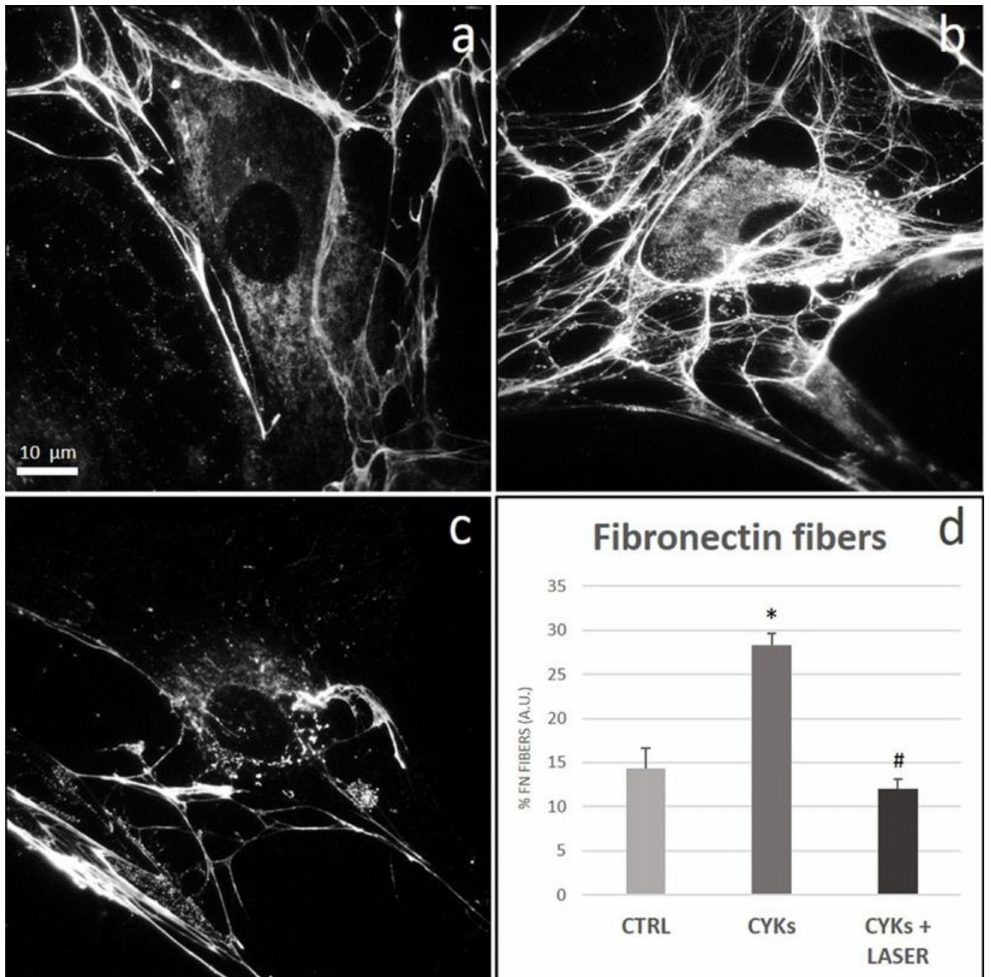
Figure 7. Effect of laser treatment on fibronectin expression and organization. Microscopy analysis of fibronectin expression evaluated by immunofluorescence (magnification 100 × ) on NHDF in basal conditions (CTRL; panel ( a )), stimulated with IL-1 β and TNF- α for 48 h (CYKs; panel ( b )), stimulated with IL-1 β and TNF- α for 48 h and then exposed to laser treatments (3 treatments, repeated once a day, for 3 consecutive days) (CYKs + Laser; panel ( c )). Bar = 10 µ m. The histogram reports the % of the surface area with fibers, acquired by ImageJ software after appropriate thresholding to only include the stained fibers (panel ( d )). * p < 0.05 CYKs group vs. CTRL group; # p < 0.05 CYKs + Laser group vs. CYKs group ( n =